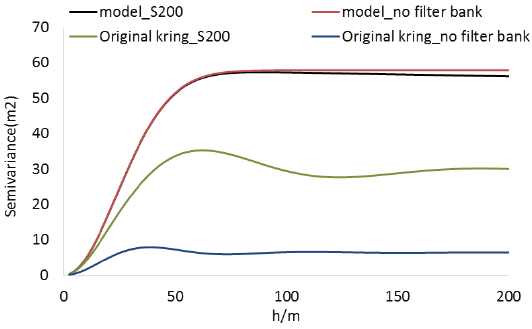
Figure A3. Semi-variograms of the highest component before and after filter bank.